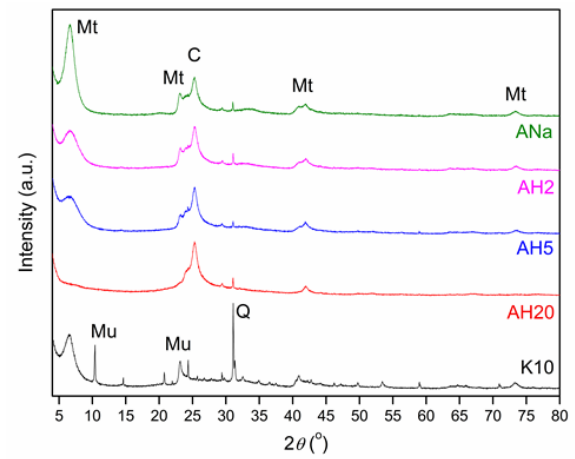
Figure 2. X-ray di ff ractograms for the montmorillonite samples. Mt stands for montmorillonite: Figure 2. X-ray diffractograms for the montmorillonite samples. Mt stands for montmorillonite: (Na,Ca)0.3(Al,Mg)2Si 4 O 10 (OH) 2 .nH 2 O; (Na,Ca)0.3(Al,Mg)2Si 4 O 10 (OH) 2 .nH 2 O; C for cristobalite: SiO 2 ; Mu for muscovite: KAl 2 (Si 3 Al)O 10 (OH) 2 and Q for quartz: SiO 2 .